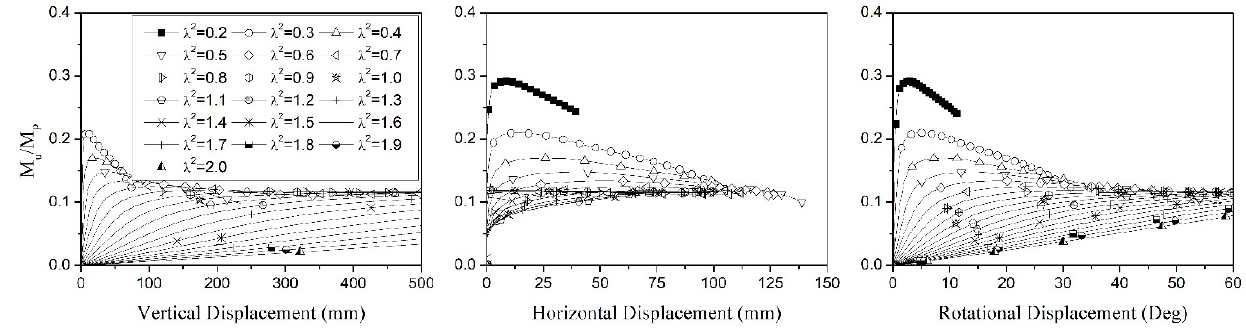
Figure 4. Load–Displacement Curve of Curved Girder ( θ = 60° )—Sec#1.